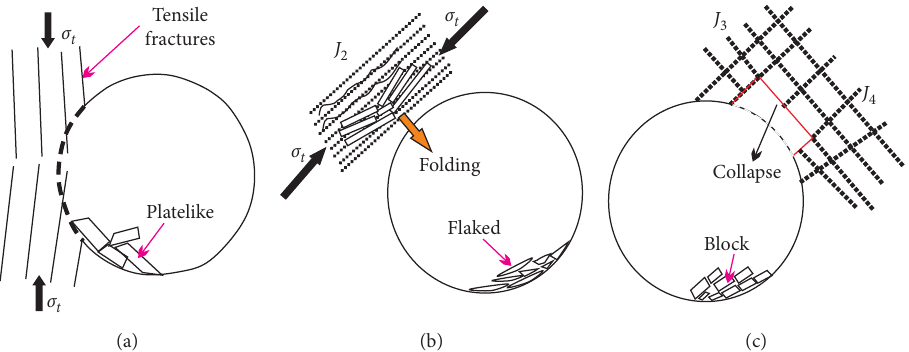
Figure 9: Failure mechanisms of typical rock bursts: (a) extrusion and slabbing, (b) folding and belling, and (c) structure planes controlled